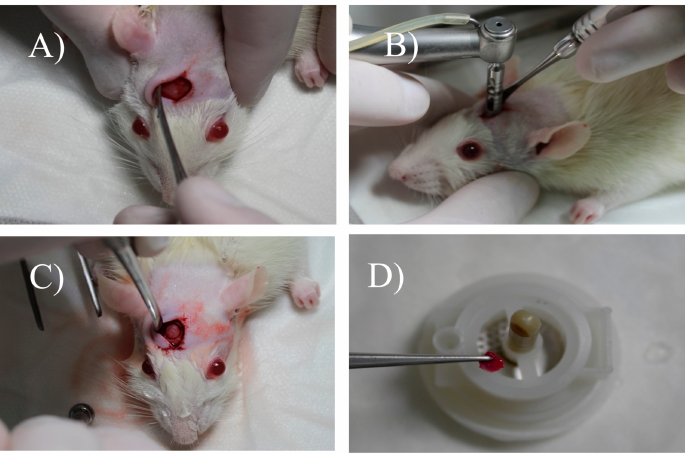
Figure 2. Surgical procedure to create the critical defect in rat calvaria and the use of Rigeneracons. ( A ) Exposure of calvaria; ( B ) use of a 5-mm trephine drill; ( C ) surgical appearance after the creation of the critical defect; ( D ) placement of the bone fragment in the Rigeneracons